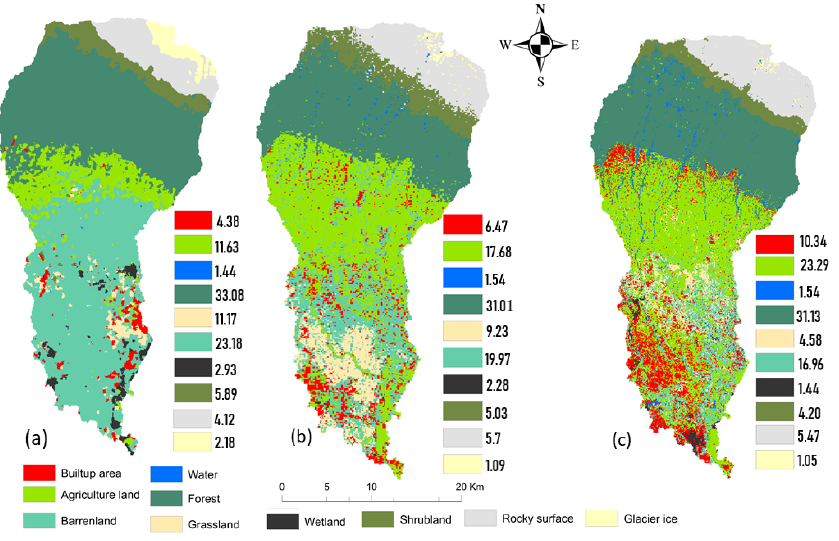
Figure 3. Percentage coverage for the land cover maps for the years 1993 ( a ), 2006 ( b ), and 2018 ( c ). Precipitation data was obtained from the four ground-based weather stations at Kil- imanjaro International airport (KIA), Lyamungu, Moshi Airport, and Kibosho Mission